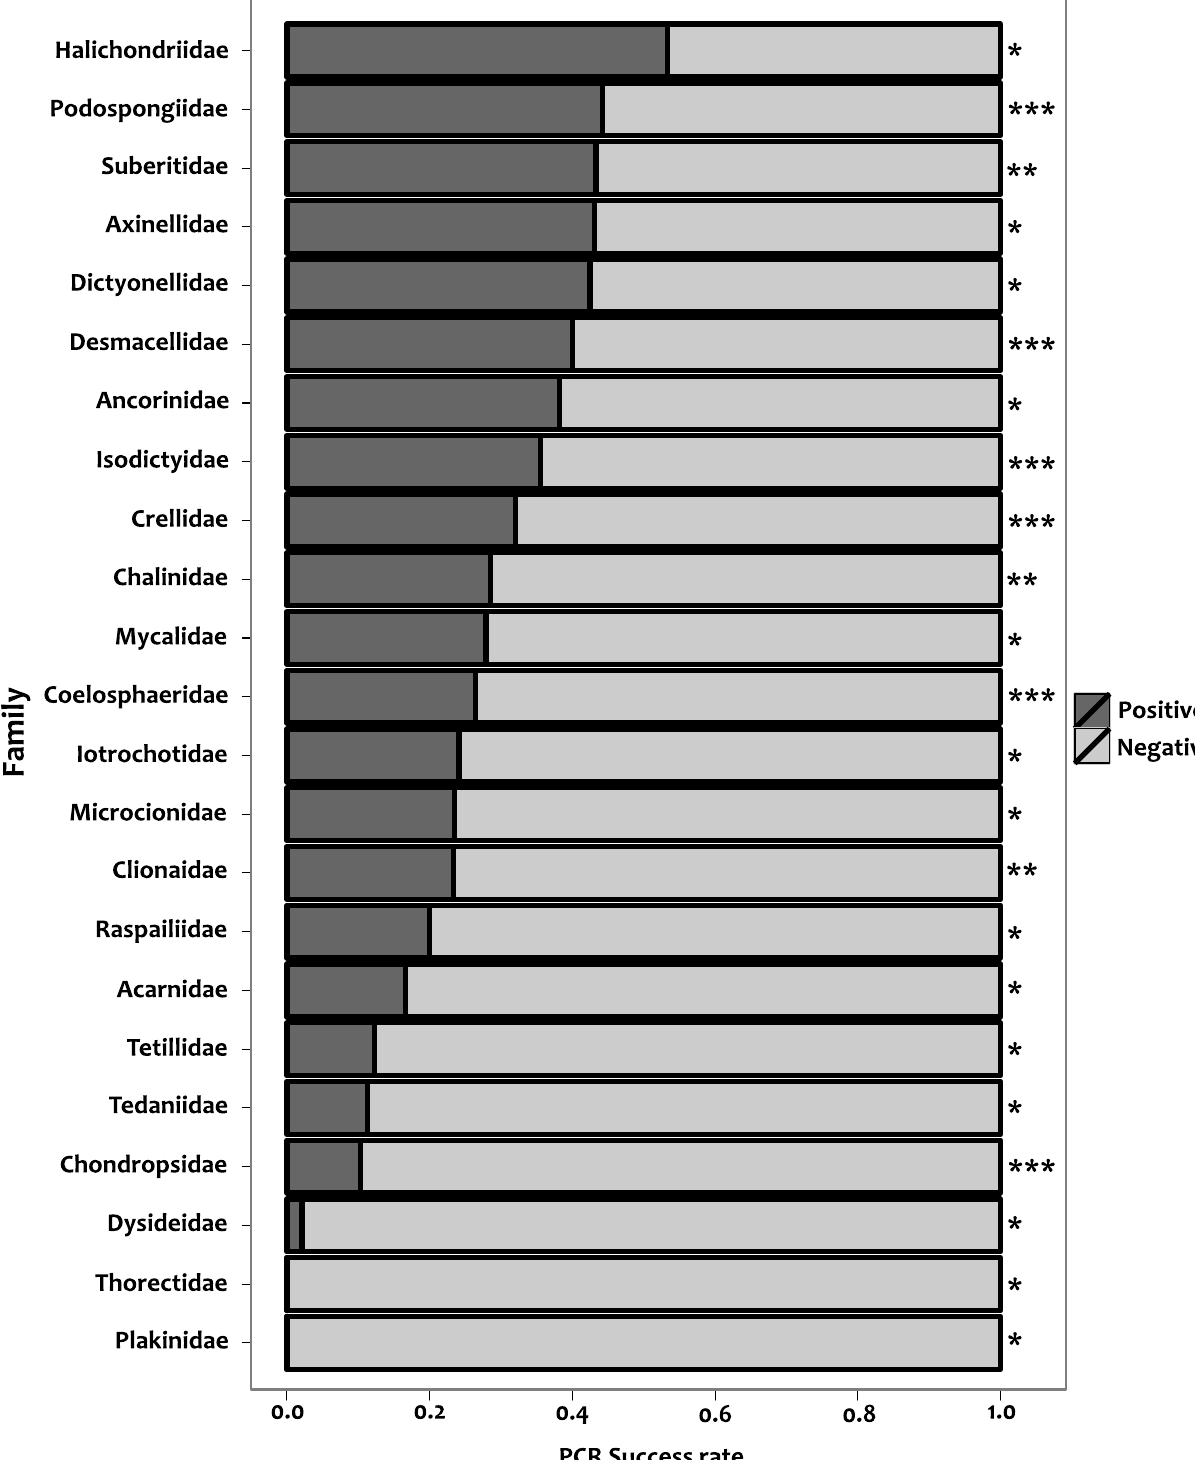
PLoS ONE | www.plosone.org 3 July 2012 | Volume 7 | Issue 7 |